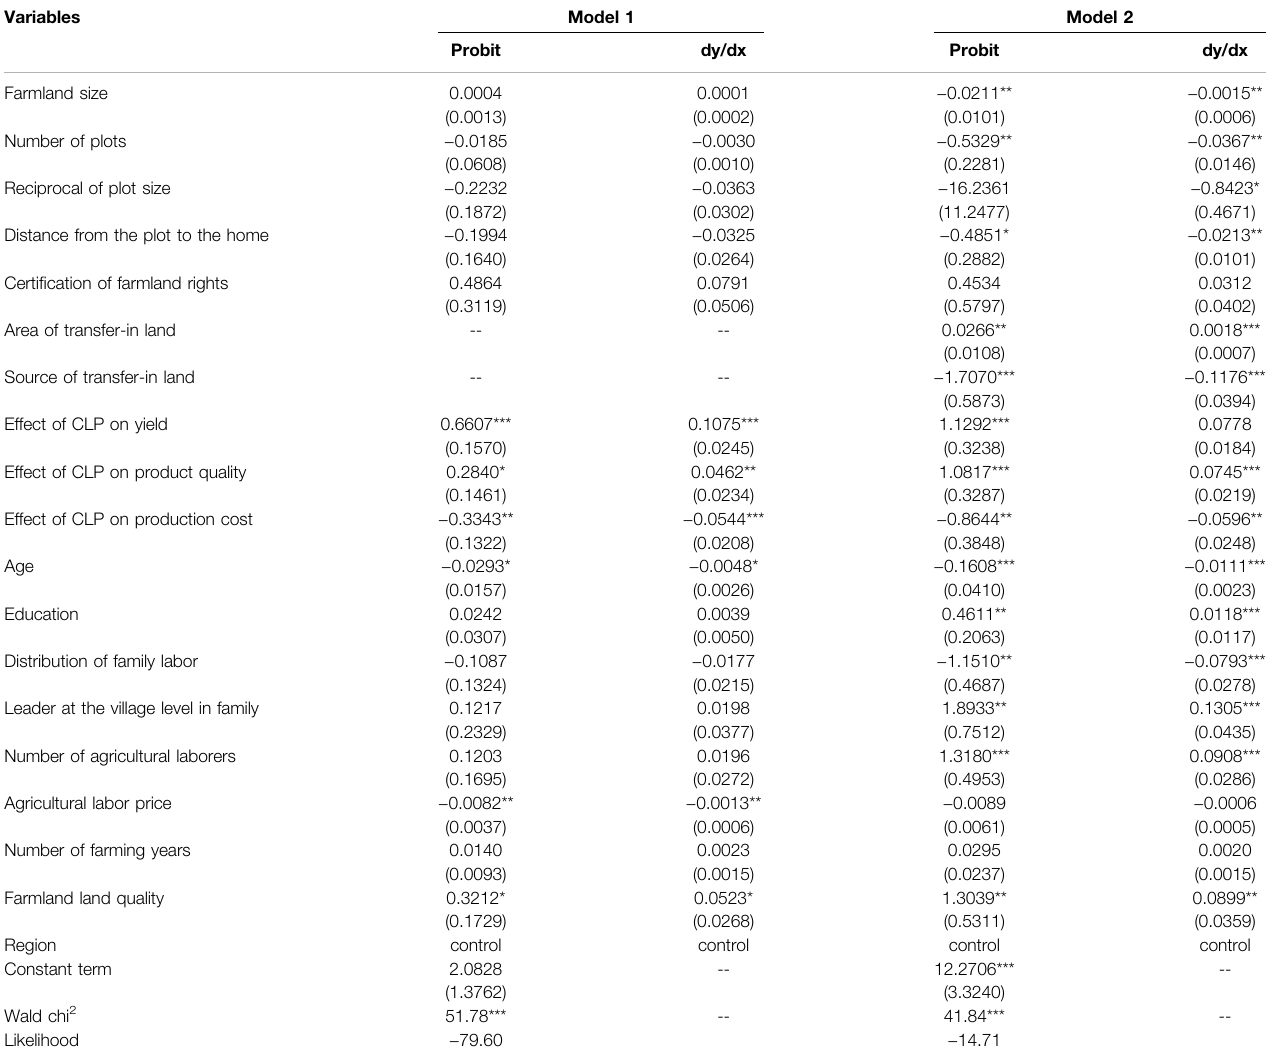
TABLE 3 | Impact of farmland transfer on farmers ’ willingness to adopt CLR.